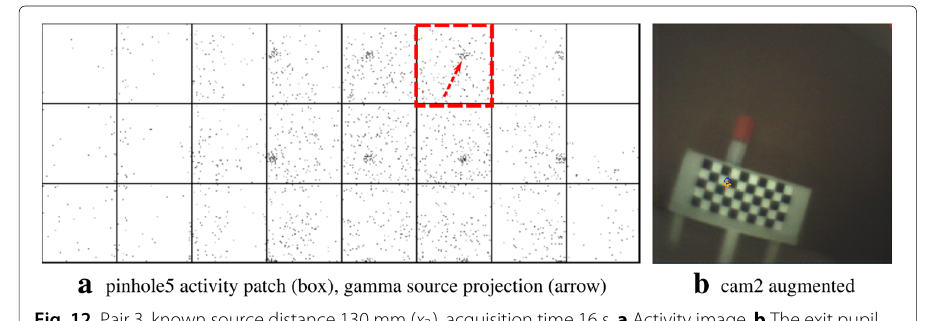
Fig. 12 Pair 3, known source distance 130 mm ( x 3 ), acquisition time 16 s. a Activity image. b The exit pupil and the activity blob show slight discrepancies